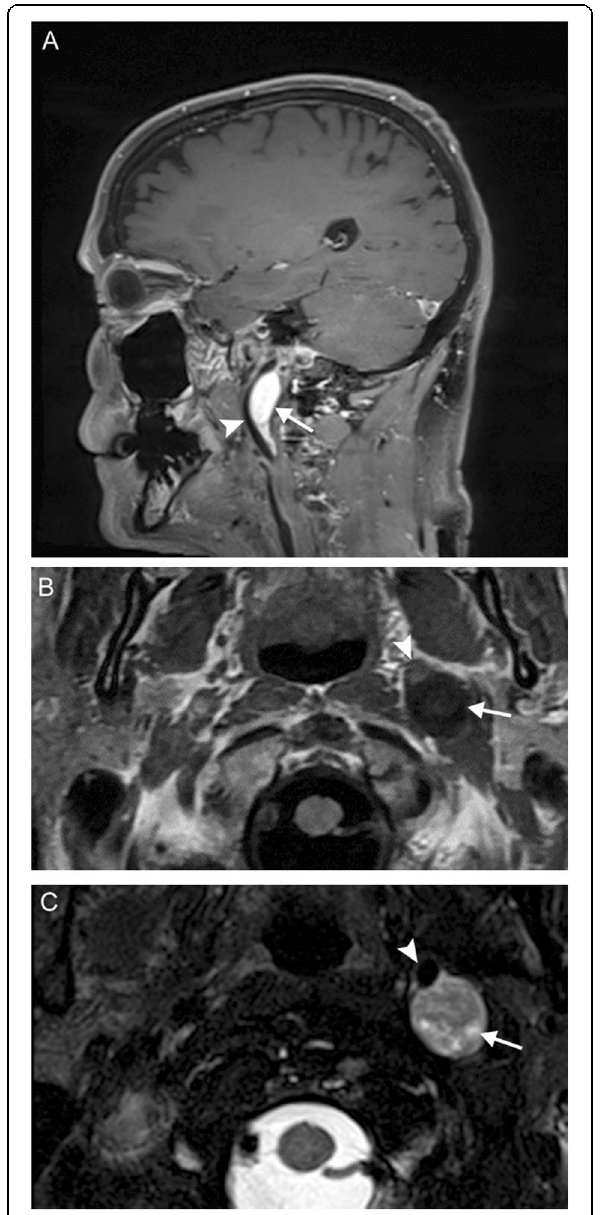
Fig. 14 Vagal paraganglioma. A 67-year-old man presenting with raspy voice. Sagittal T1 post-contrast ( a ), axial T1 ( b ), and axial T2 ( c ) MR images reveal a T1-hypointense, avidly enhancing lesion with heterogeneous areas of high T2 signal (arrows) centered within the left carotid space. The internal carotid artery is displaced anteromedially (arrowheads). Pathology was consistent with a vagal